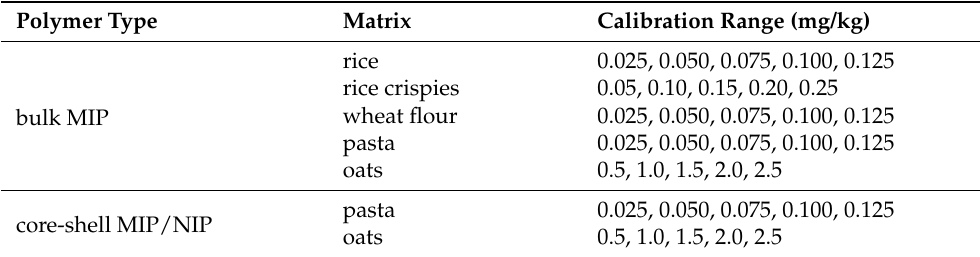
Table 8. Matrix-matched calibration levels for bulk and core-shell MIP and NIP.